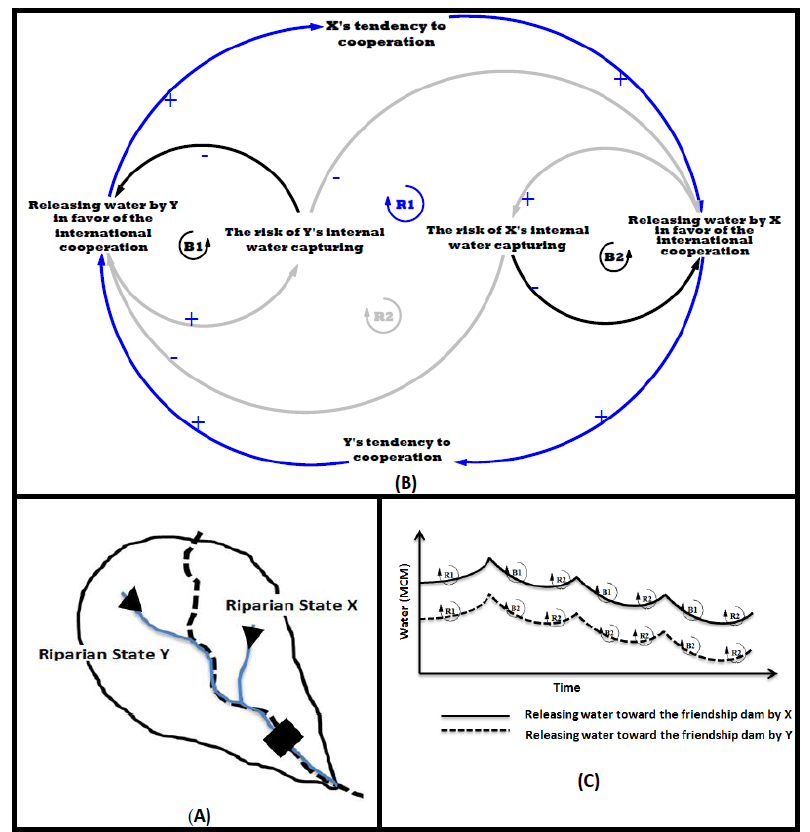
Figure 2. ( A ) The schematic of the physical environment that can embrace HSA2 (real cases in Appendix A, Table A2). ( B ) The “small players with the big game” archetype. ( C ) The schematic of the potential behavior of HSA2 and responsible loops.